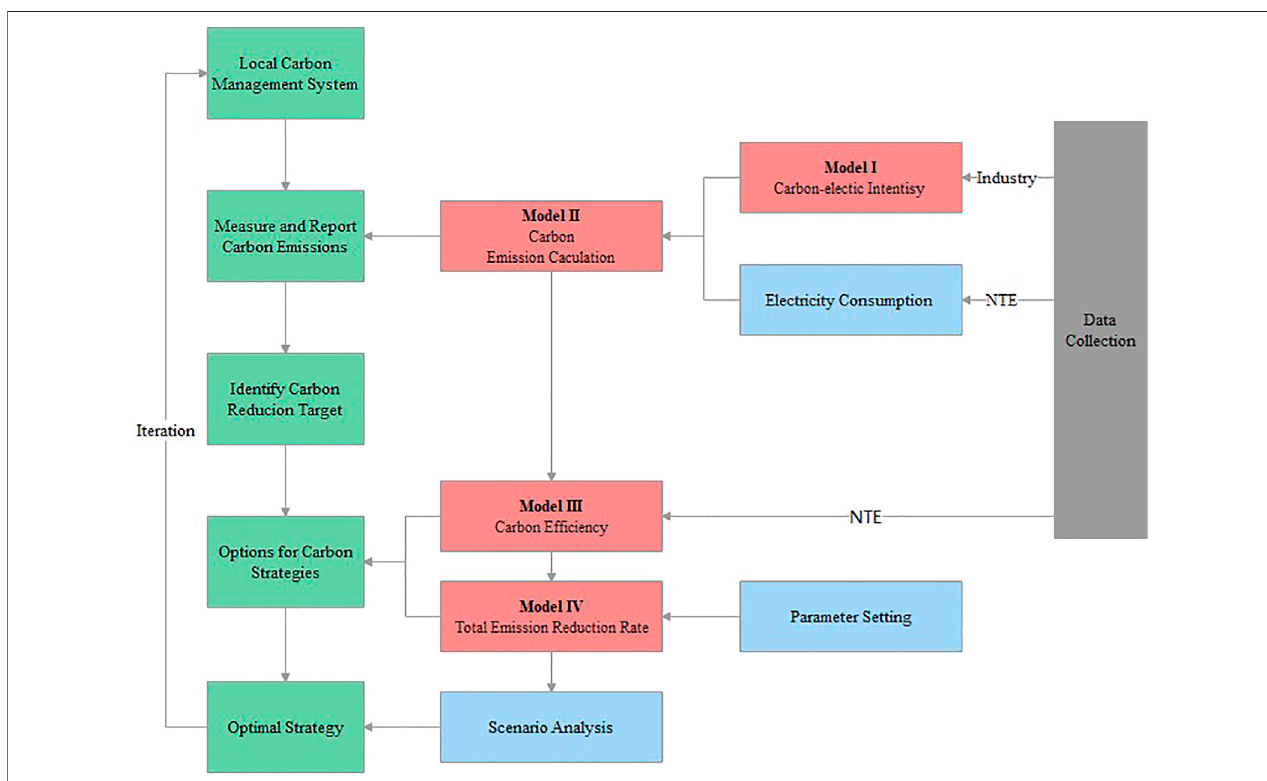
FIGURE 1 | The process of establishing a regional carbon management